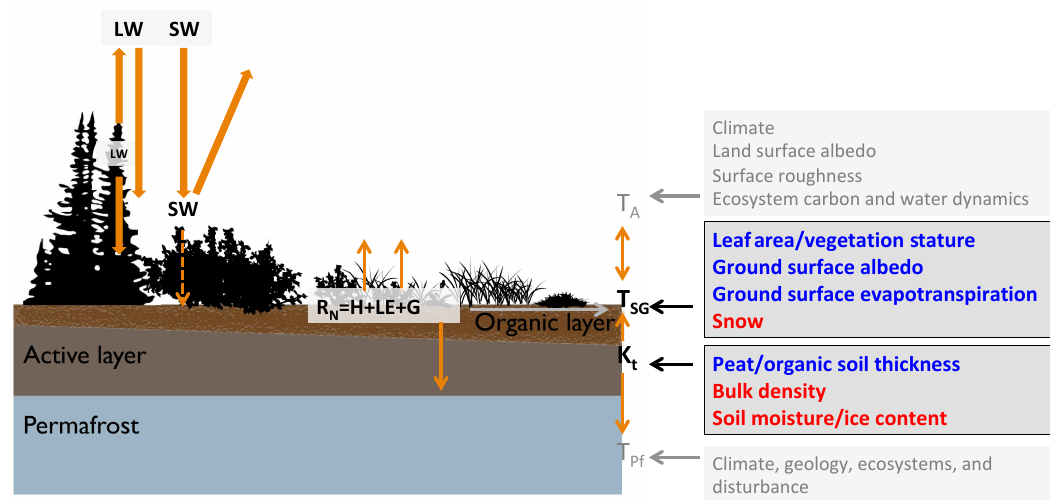
Figure 1. Key ecosystem controls on surface energy partitioning in relation to permafrost soil thermal dynamics (energy fluxes are indicated by orange arrows). Net radiation ( R N ) is balanced by sensible ( H ), latent (LE), and ground ( G ) heat fluxes. Ground surface temperature ( T SG ) and soil thermal conductivity ( K T ) exert strong controls on G and are strongly influenced by a variety of ecosystem controls (indicated in dark gray boxes; red and blue text denote soil cooling and warming effects, respectively). Controls on air ( T A ) and permafrost ( T Pf ) temperatures are driven largely by climate, and we assume that ecosystem impacts on these variables are negligible on short timescales (e.g., seasonal to annual) and small spatial scales (e.g., m 2 to km 2 ) relative to factors highlighted in dark